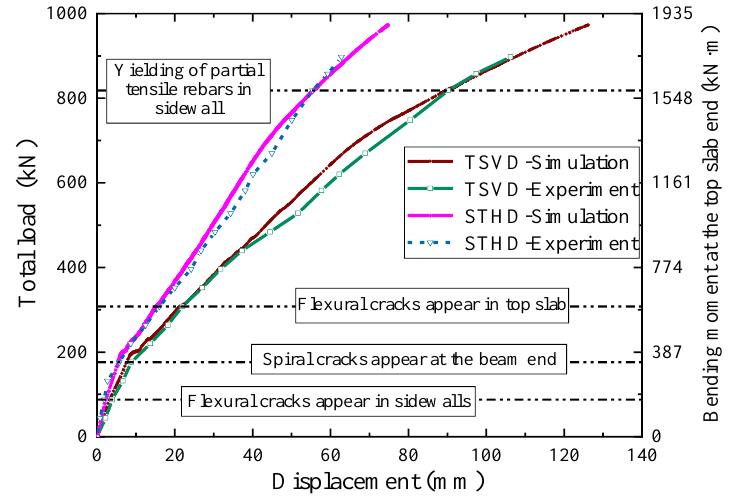
Figure 18. Comparison of load–deformation responses.